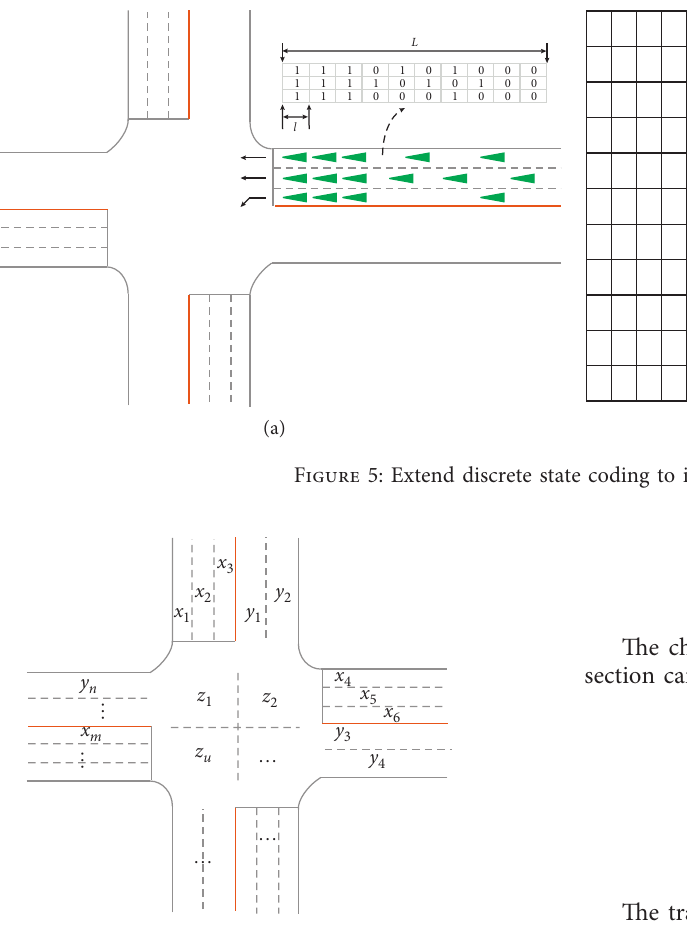
Figure 6: Combination of key parts at